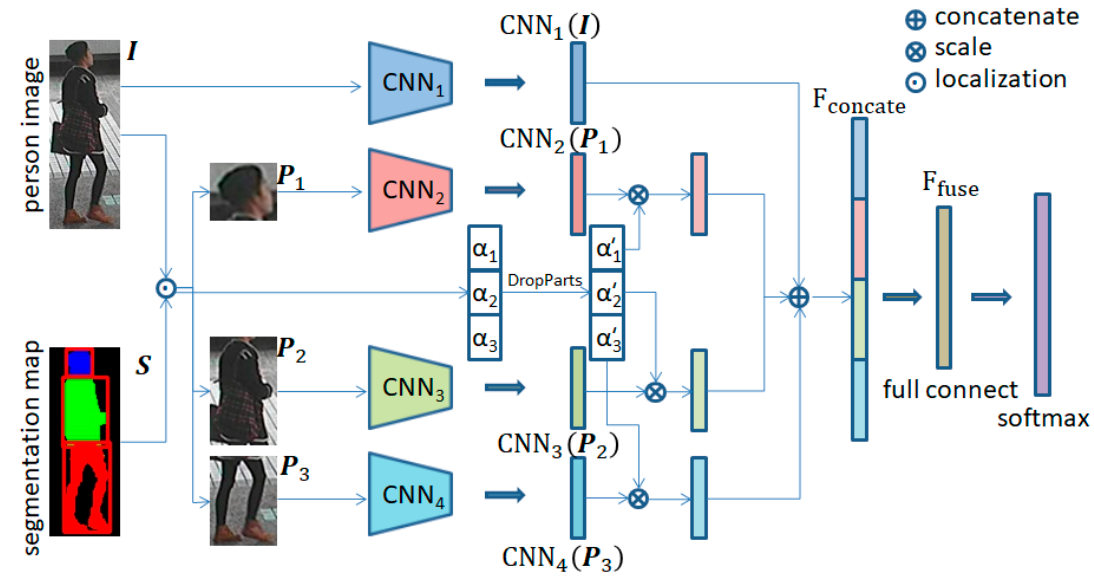
Figure 2. The architecture of proposed parts aware person re-identification network. The network consists of four convolutional neural network branches which learn person appearance and three body parts feature maps respectively, and then fuses four feature maps to an image descriptor. Its input images include a whole person image, head part patch, torso part patch and lower-body part patch. Each branch learns the representation of the whole person image or part patch and finally is fused by a concatenation layer and a fully connected layer.